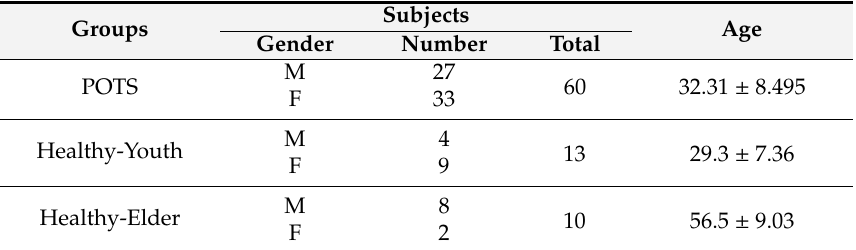
Table 1. Basic data of the three subject